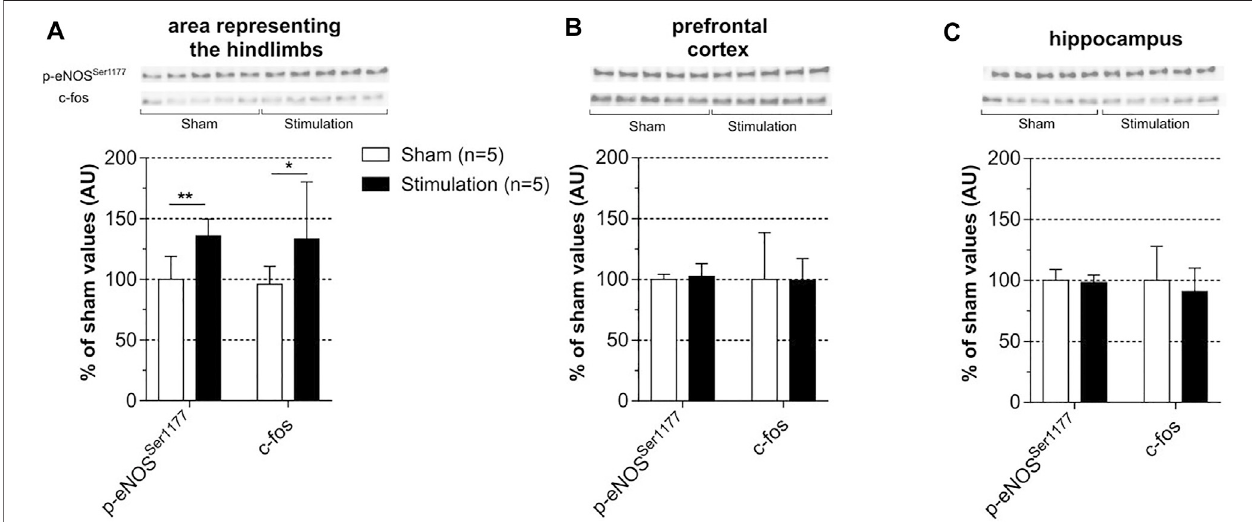
FIGURE 7 | Effect of subchronic stimulation on p-eNOS Ser1177 and c-fos brain levels. Levels of c-fos and p-eNOS Ser1177 were measured in the area representing thehindlimb (A) ,prefrontalcortex (B) andhippocampus (C) 24 hafterthelastsessionofa30 minelectricallyinducedcontractionofhindlimbs(5xMT)repeatedduring7 consecutive days in rats anesthetized with iso fl urane and in sham unstimulated. Values are expressed as means ± SD, n = number of rats. * ( p < 0.05) and ** ( p < 0.01) signi fi cantly different from sham rat values after t -test.